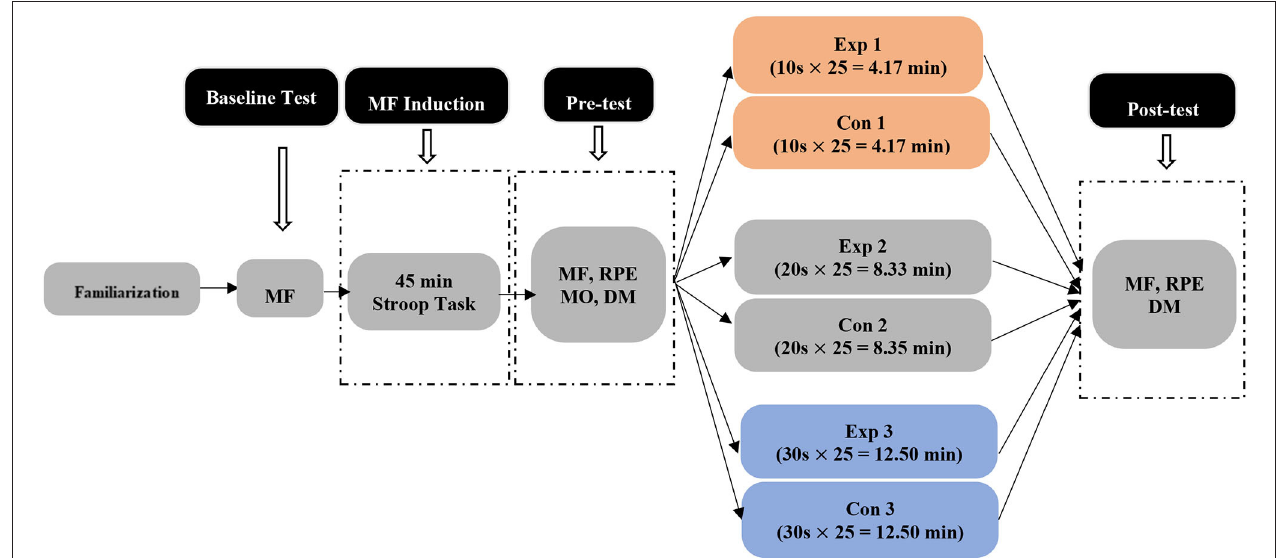
FIGURE 1 | Experimental design. MF, Mental fatigue; MO, motivation; RPE, rating perception of effort; Exp 1, experimental group 1; Con 1, control group 1; Exp 2, experimental group 2; Con 2, control group 2; Exp 3, experimental group 3; Con 3, control group 3.